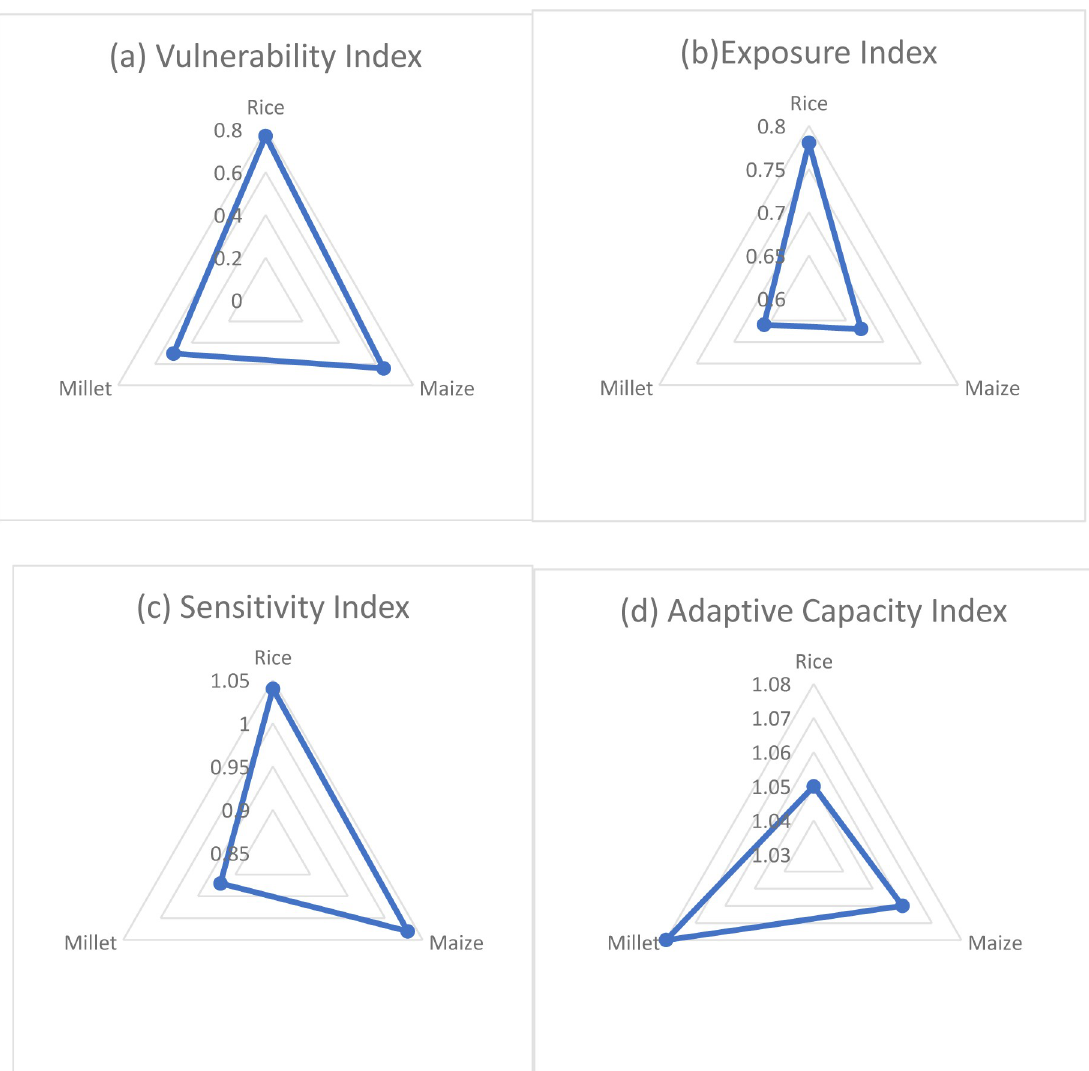
Fig 8. Simulated national scale (a) Vulnerability Index, (b) Exposure index, (c) Sensitivity Index and (d) Adaptive Capacity Index for Cameroon. Source: Authors’ conceptualization.